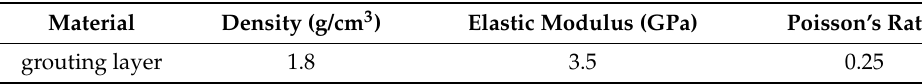
Table 4. Parameters of the grouting